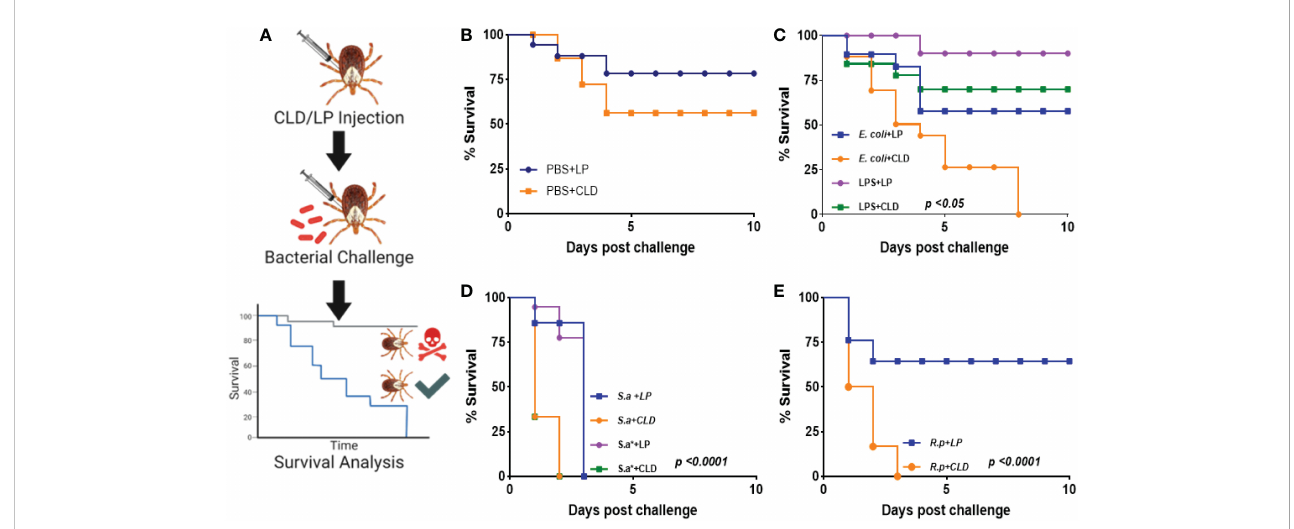
FIGURE 4 Depletion of phagocytic hemocytes impairs survival against bacterial challenges. Unfed female Am. maculatum were injected with either LP or CLD at 1:5 dilution and 24 h later challenged with bacteria or sterilely injured (A) . Tick survival was monitored every 24 h for 10 days to evaluate the effect of sterile injury (B) , E . coli (C) , S. aureus (D) , or R. parkeri (E) challenge. Data were analyzed with the log-rank (Mantel-Cox) in GraphPad Prism v8.4.1. S.a: live S. aureus, S.a*: heat-killed S. aureus, R.p: R. parkeri